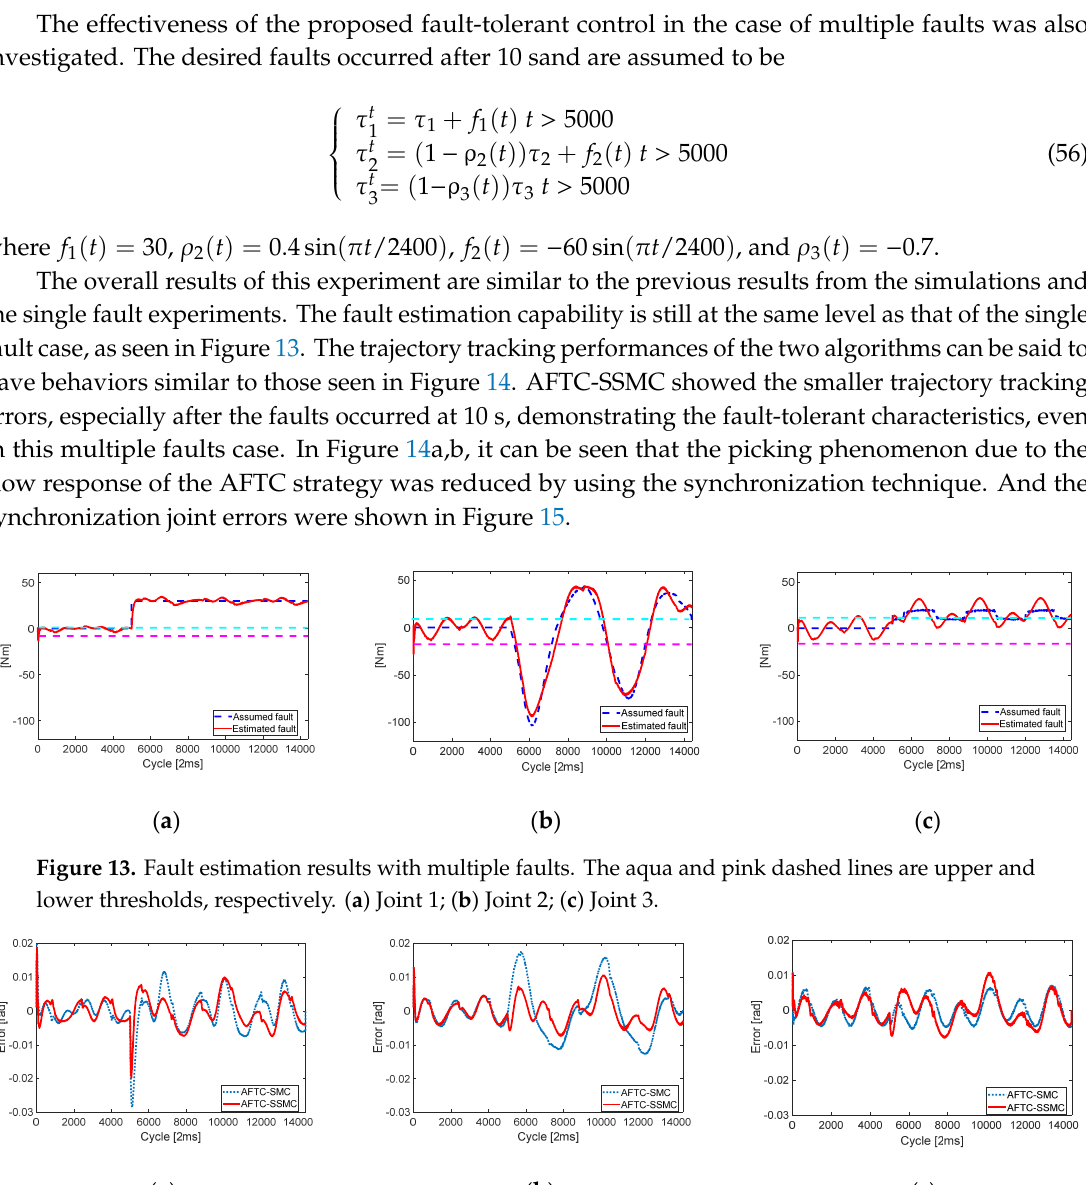
Figure 12. The synchronization error with a single joint fault occurring at Joint 2. ( a ) Joint 1; ( b ) Joint 2; ( c ) Joint 3.